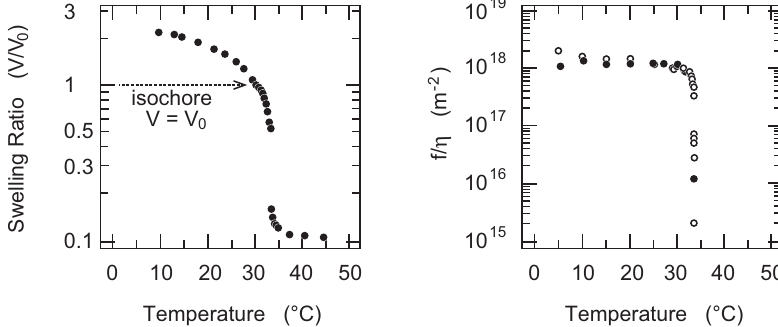
Figure 8. The temperature dependence of the swelling ratio of gel (left; V / V 0 ) and that of the friction coefficient of poly( N -siopropylacrylamide) (PNIPA) gel that is normalized by the viscosity of water (right; f ( T ) / η ( T ) ). The friction is measured under a constant volume condition that is shown in the left figure as an arrow. Open circles are used in the increasing of the temperature and solid circles are used in the lowering of the